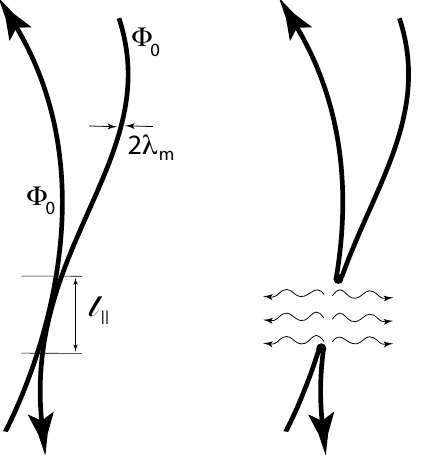
Fig. 3. Annihilation of the strictly antiparallel sections of two con- tacting magnetic field lines of diameter 2 λ m , each carrying just one flux quantum 8 0 . Annihilation proceeds over the antiparallel length ‘ k only, thereby creating two new field lines each one, as before, carrying just one flux quantum 8 0 . The annihilation releases the magnetic energy stored in the common volume V 0 = 2 πλ 2 m ‘ k of the two contacting strictly antiparallel flux tube sections. The re- leased energy heats the plasma locally. The strong bending of the remaining (reconnected) parts of the field lines causes relaxation and stretching of the newly reconnected field lines but does not ex- ert any forces on the plasma on the narrow sub-gyroscale of one single field line, causing them to relax as if in